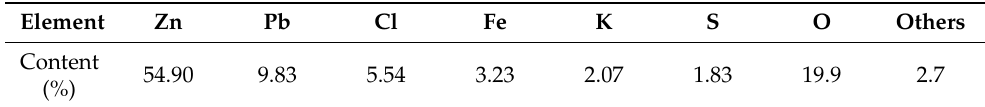
Table 1. The main composition of SZO.